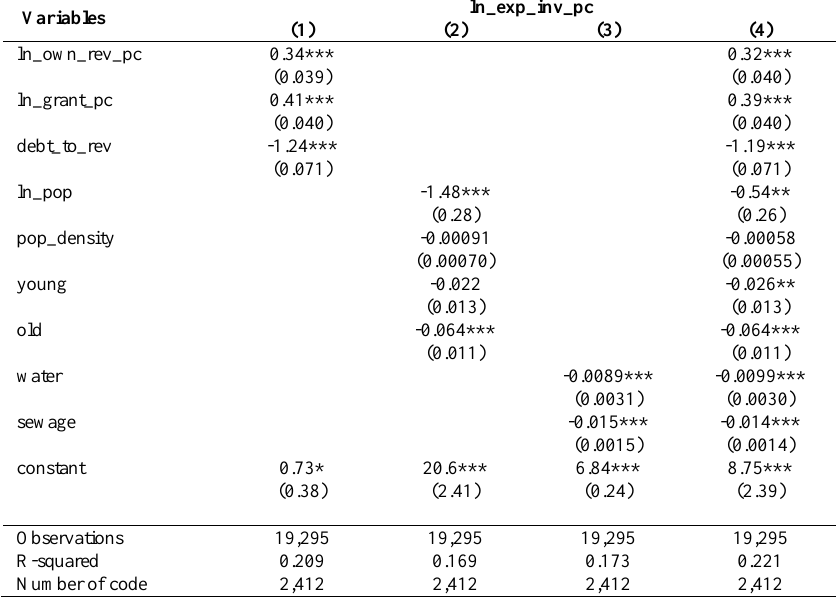
Table 3. Fixed effects (FE) regression results for municipalities excluding cities with county rights in the years 2007–2014